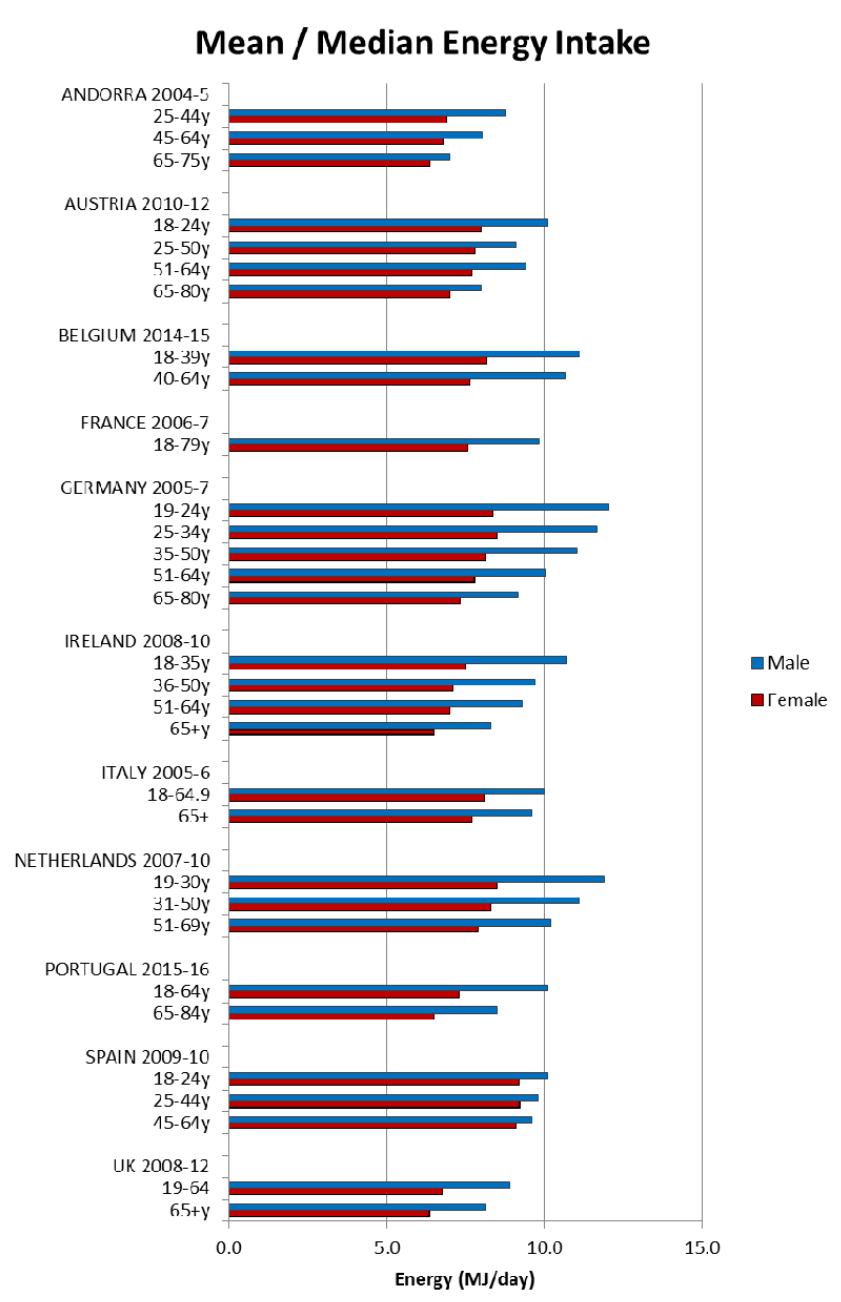
Figure 1. Mean/median* adult energy intake (MJ/day) for Western European countries (excluding supplements). * Figures for Spain are based on median rather than mean values.